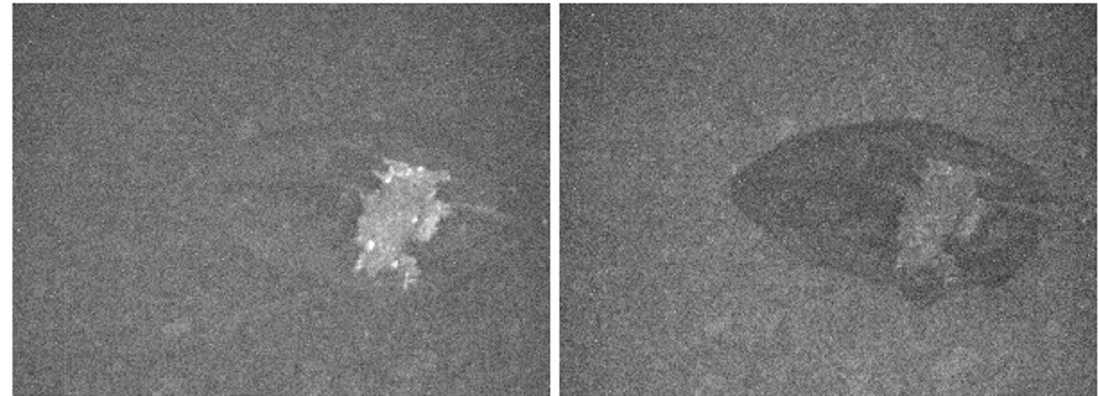
Figure 7. Gain 20 ( left ) and gain 32 ( right ) images at 525 nm of manure on a spinach leaf. Images were acquired near solar noon with the drape fully lowered.